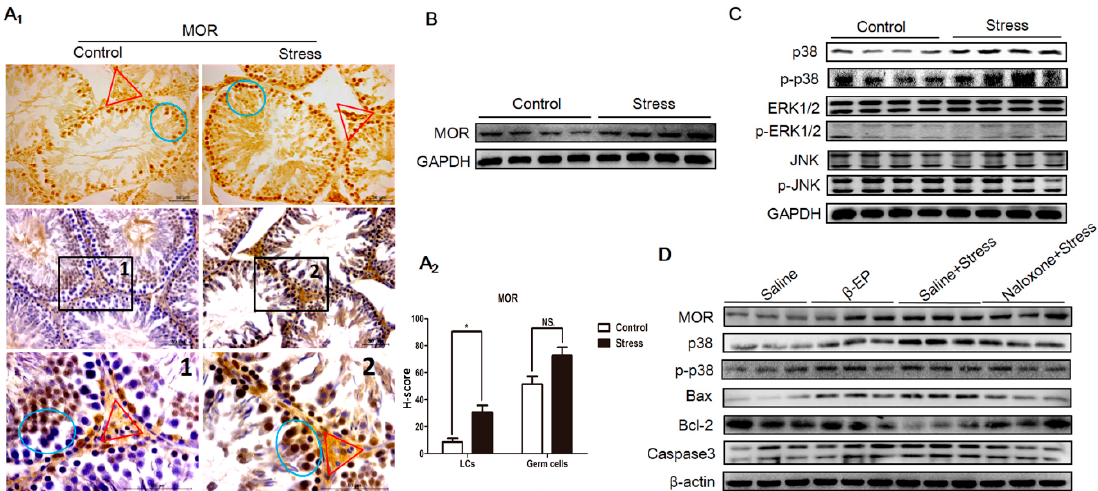
Figure 4. PS-induced apoptosis is associated with overexpression of MORs in testes and activation of the p38 MAPK pathway. ( A1 ) Elevated expression of MOR in LCs (red triangle) and germ cells (blue circle in the seminiferous tubule) as evidenced by immunohistochemistry. DAB (Diaminobenzidine) detection, hematoxylin counterstaining, and partially magnify after counterstaining were showed in testicular tissue sections. ( A2 ) H-scores of both LCs and germ cells demonstrated that MOR in LCs were significantly higher in the stress group vs. the control group. ( B ) Elevated MOR expression in testes as indicated by Western blotting. ( C ) Selective phospho-activation of p38 MAPK but not ERK1 / 2 or JNK in the testis of PS rats as indicated by Western blotting. ( D ) Elevated MOR, p38 MAPK, Bax, and caspase 3 expression in the testis of β -EP-injected rats and reversal by naloxone.